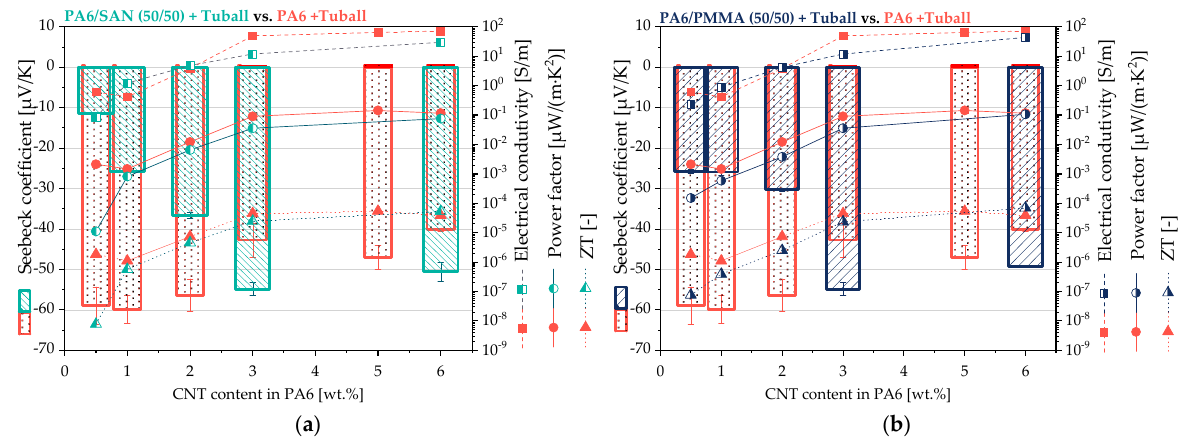
Figure 12. Thermoelectric parameters of ( a ) PA6/SAN/SWCNT blends and ( b ) PA6/PMMA/SWCNT blends having 50/50 wt.% ratio of the blend components and different SWCNT contents (0.25–3 wt.%) (values given in Tables A2 and A3) in comparison to PA6/SWCNT composites (in red). The CNT contents were calculated under the assumption that the SWCNTs are completely localized in PA6.